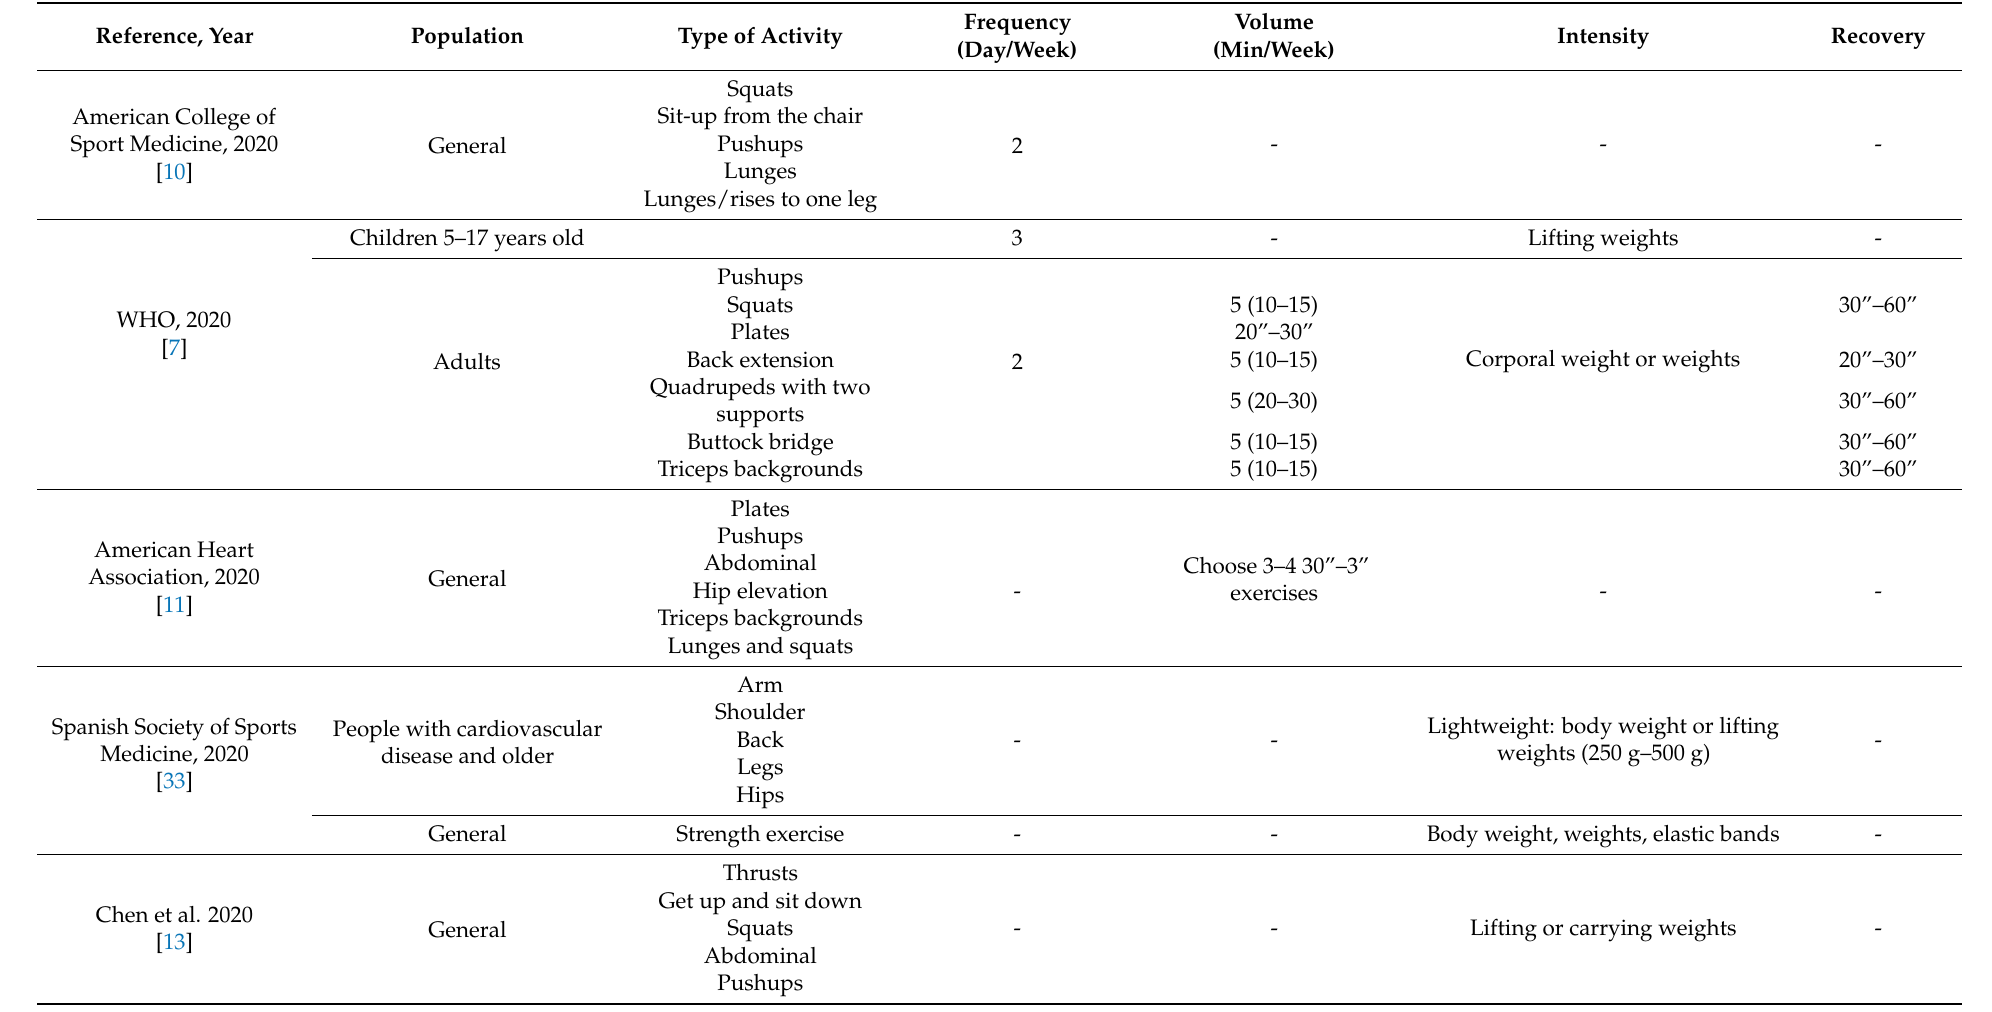
Table 2. Strength training